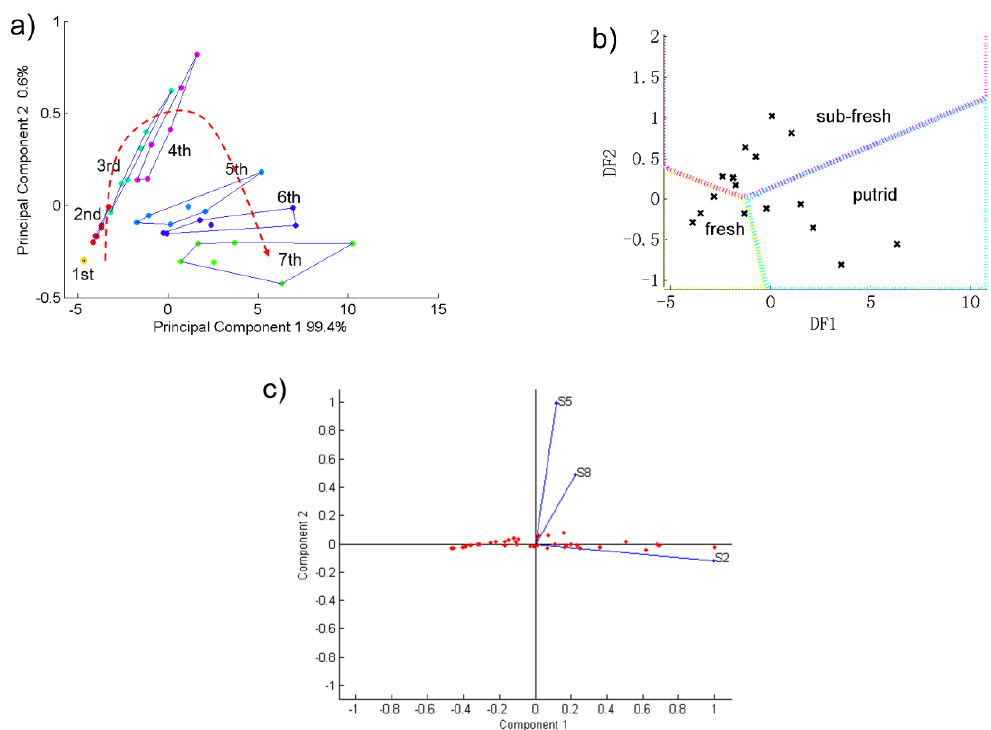
Figure 4. The results of pork samples with different storage time during 7 days: ( a ) PCA result; ( b ) DFA result and ( c ) Loading plot figure. Table 3. DFA result of 19 unknown pork